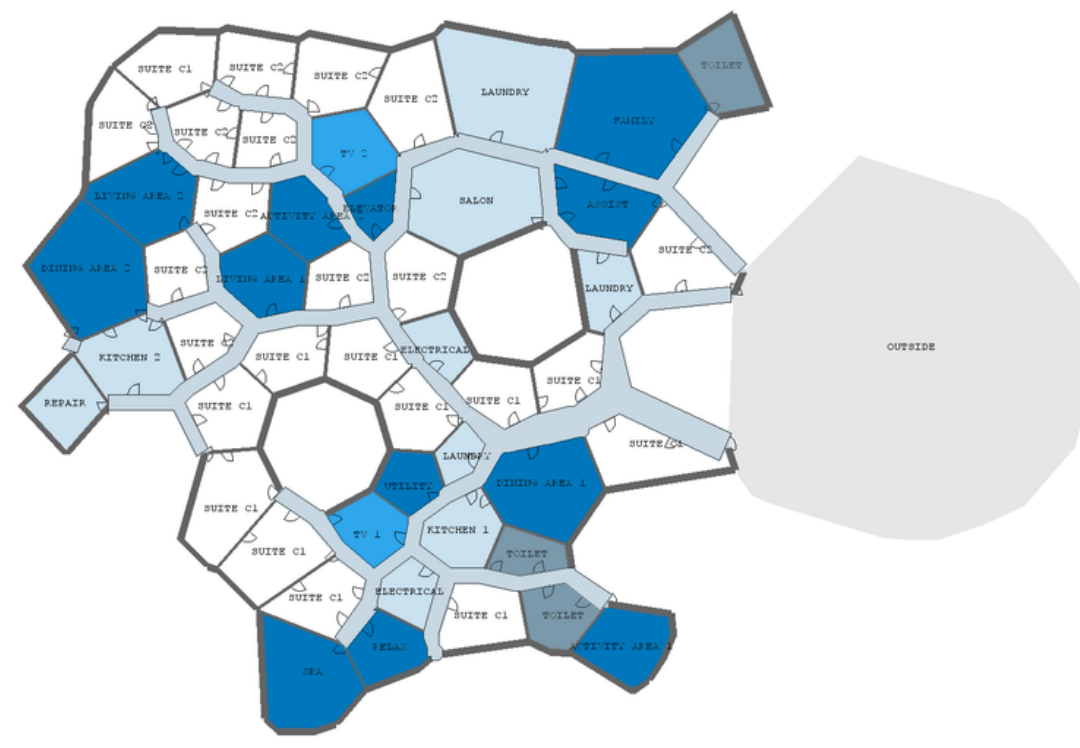
Figure 1. Self-organized plan with NEAT where optimization criteria based on care home residents’ need have been applied. This figure illustrates one of the spatial configurations obtained as the result of the generative process where distances among rooms and the position of each area is optimized according to a set of given design criteria. From Carta et al.